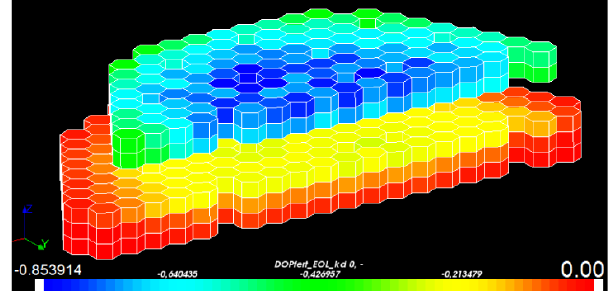
Fig. 13. 3D map of Doppler coef fi cients (pcm) in fertile